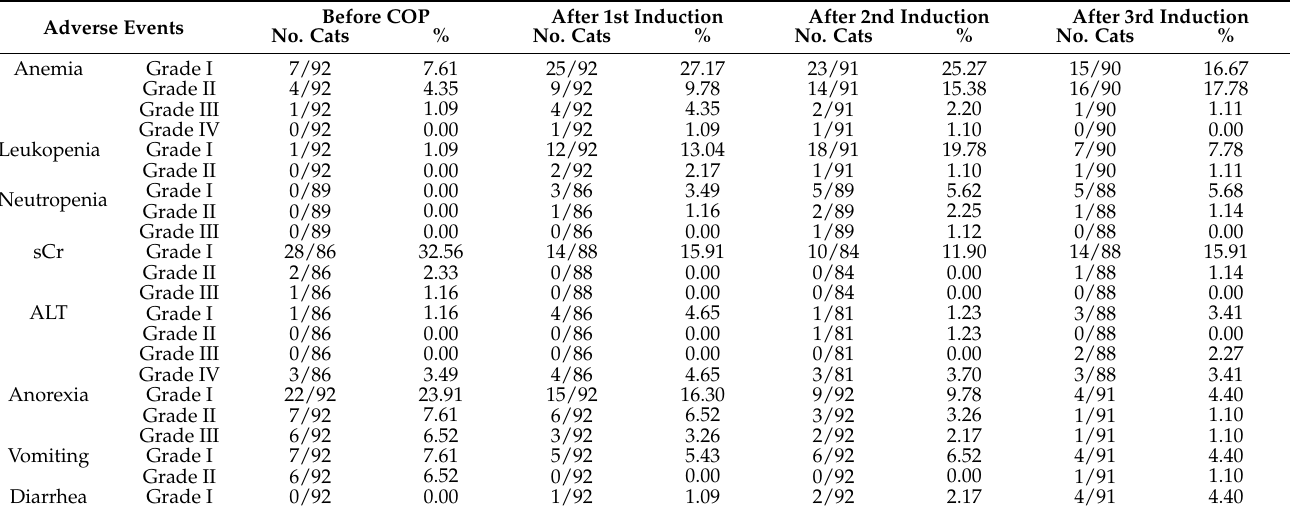
Table 3. Adverse events related to COP chemotherapy in